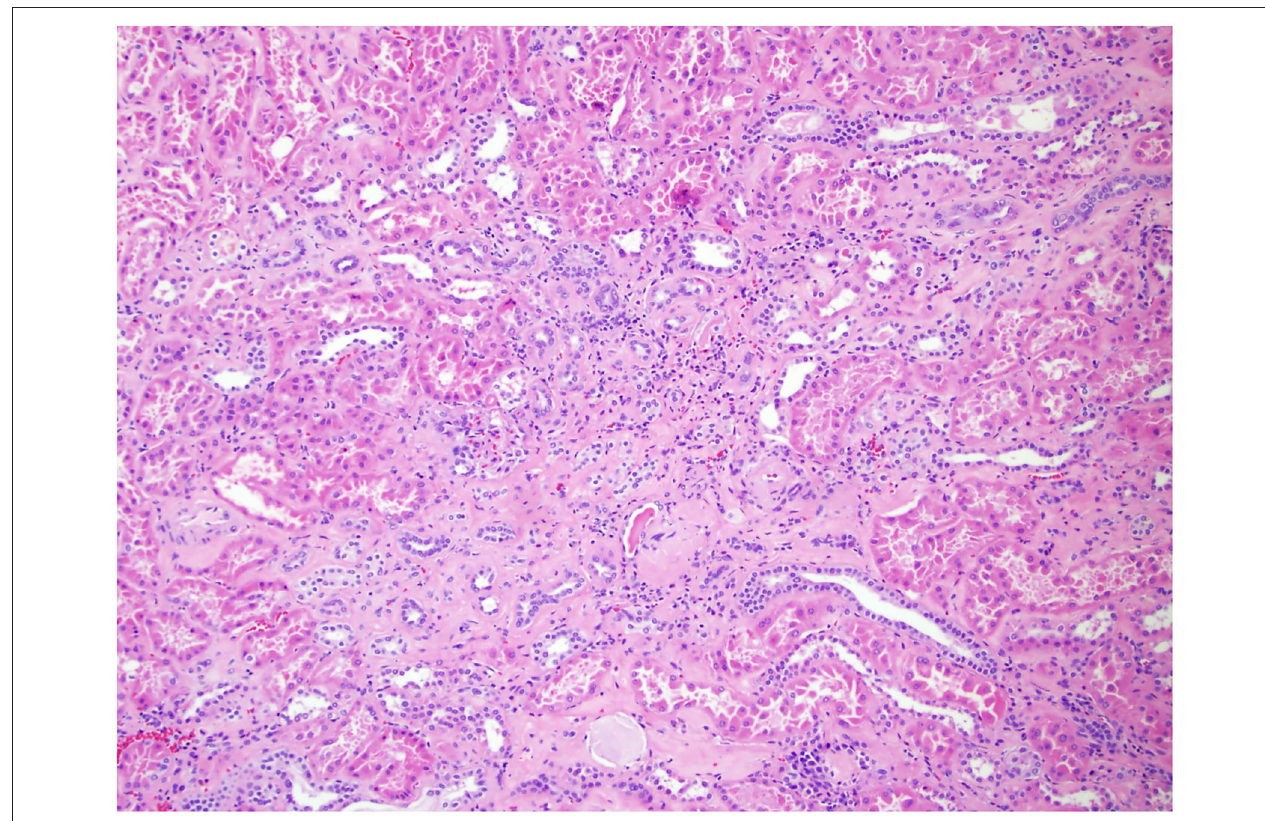
FIGURE 2 | Non-neoplastic renal tissue on 100 × of a patient with TD. Pictured here is interstitial disease, evidenced by the interstitial fibrosis and chronic inflammation.